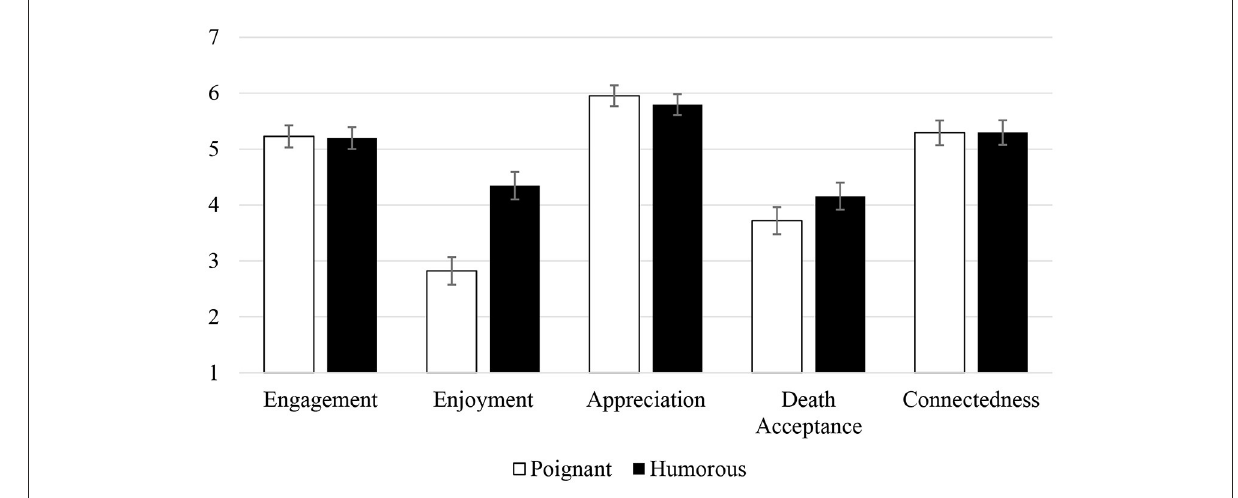
FIGURE2 Estimated marginal means of narrative and outcome variables by condition.